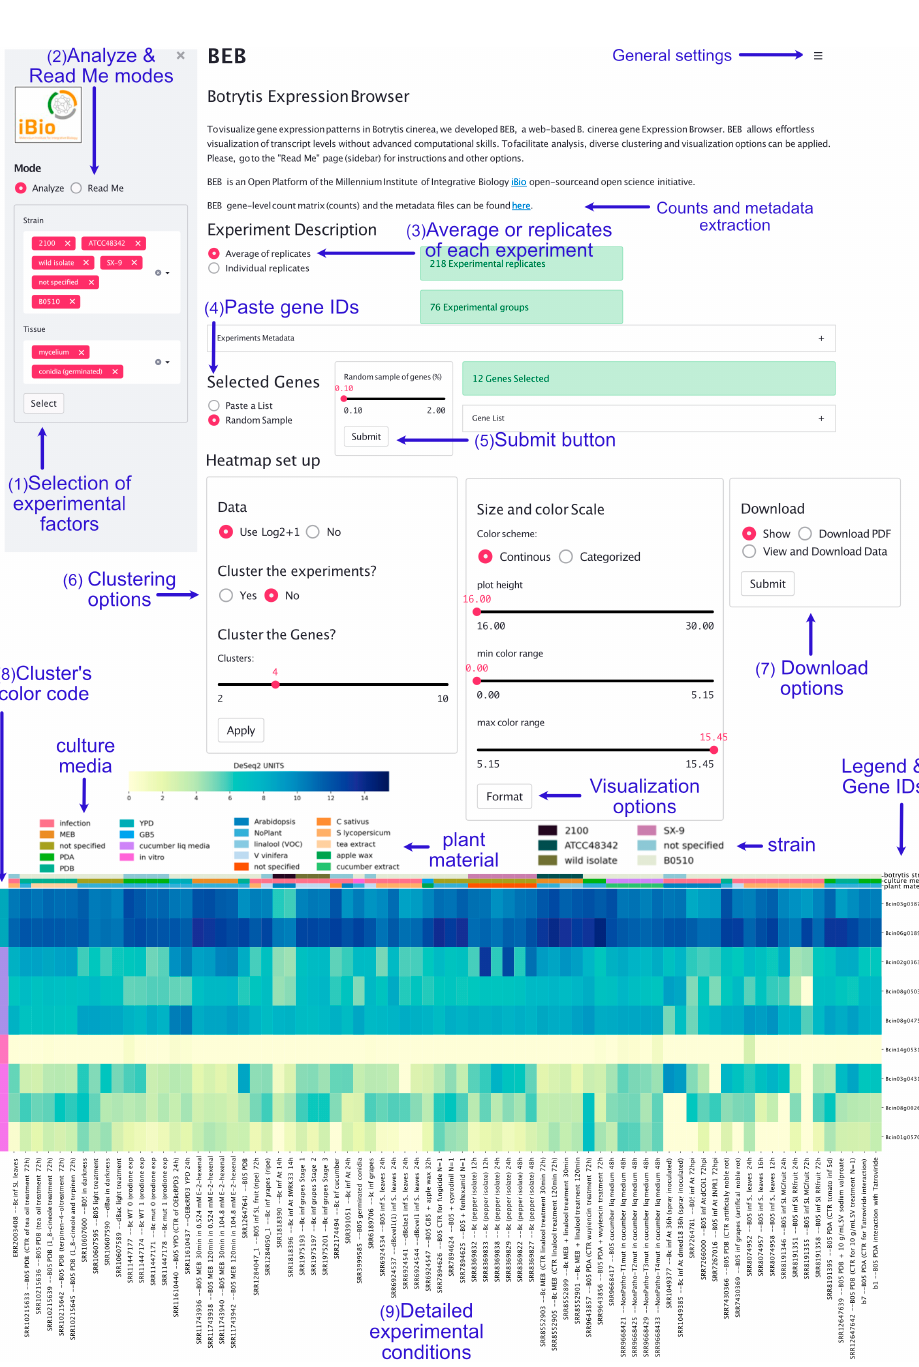
Figure 1. B. cinerea gene Expression Browser (BEB) graphical user interface. The BEB landing page contains a left sidebar section where experimental factors can be selected (1). The “Analyze” and “Read Me” modes (2) are available on the left sidebar (top section). Detailed instructions on how to use BEB are available in the latter display tool. In the upper section, users can choose to display average expression values or values for each replicate individually (3). Users can copy, paste, and submit gene IDs in the middle right section after selecting the “Paste a List” option (4). After clicking the “Submit” button (5), a heatmap depicting gene expression levels is generated at the bottom of the webpage. Clustering (6) and download options (7) are available in the middle section. BEB clusters are denoted with a color code shown at the outmost left column of the heatmap (8). A detailed description of each experiment is provided at the bottom of the figure, including SRA IDs (9).